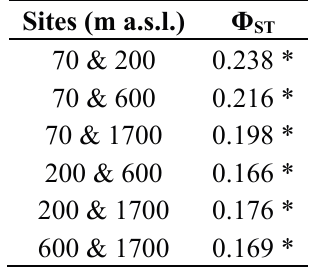
Table 3. Paired AMOVA between sites on the Colipa